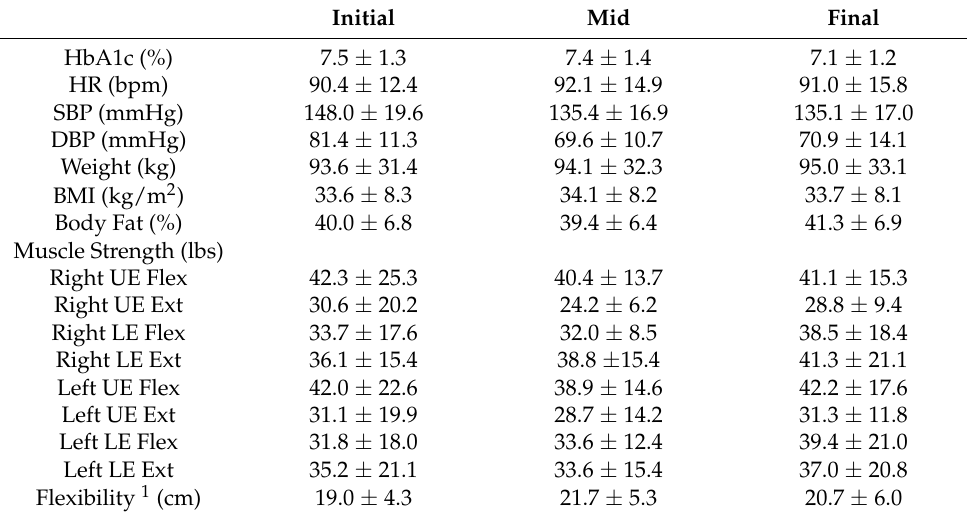
Table 1. Results for Physical